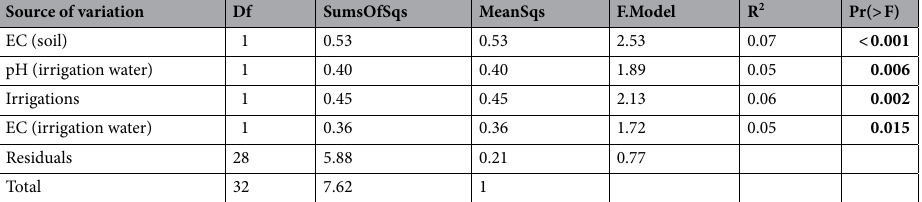
Table 1. PERMANOVA analysis showing effects of different irrigation sources (non-saline vs saline water) on date palm root-associated bacterial community compositional structure. Effects of irrigation source, irrigation water pH, irrigation water EC (dS/m); soil (pH, EC, and organic matter (OM) chemistry were tested on overall bacterial communities. P ‐ values were obtained using 9999 permutations, and boldface indicates statistical significance ( P <